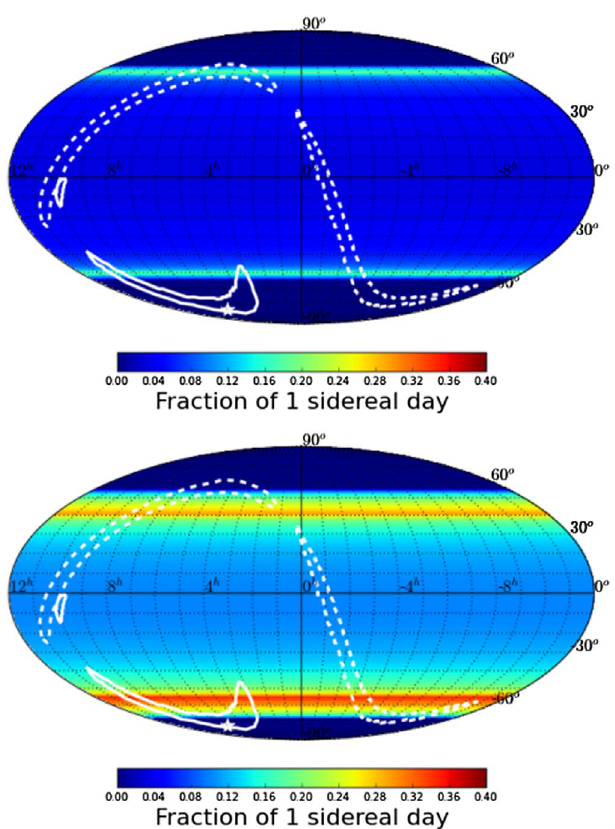
Figure 7. Skymaps in equatorial coordinates of the visibility by the Pierre Auger Observatory during both BBH events. The colorscale indicates the fraction of a day each portion of the sky is visible by the Pierre Auger Observatory SD in the ES channel (top pannel) and the DG channel (bottom pannel). The white solid line represents the 90% CL position of GW150914, the dashed line is the 90% CL location of event GW151226 and the white star is the best- fi t location of GW150914 obtained with data from the Fermi-GBM instrument. Taken from